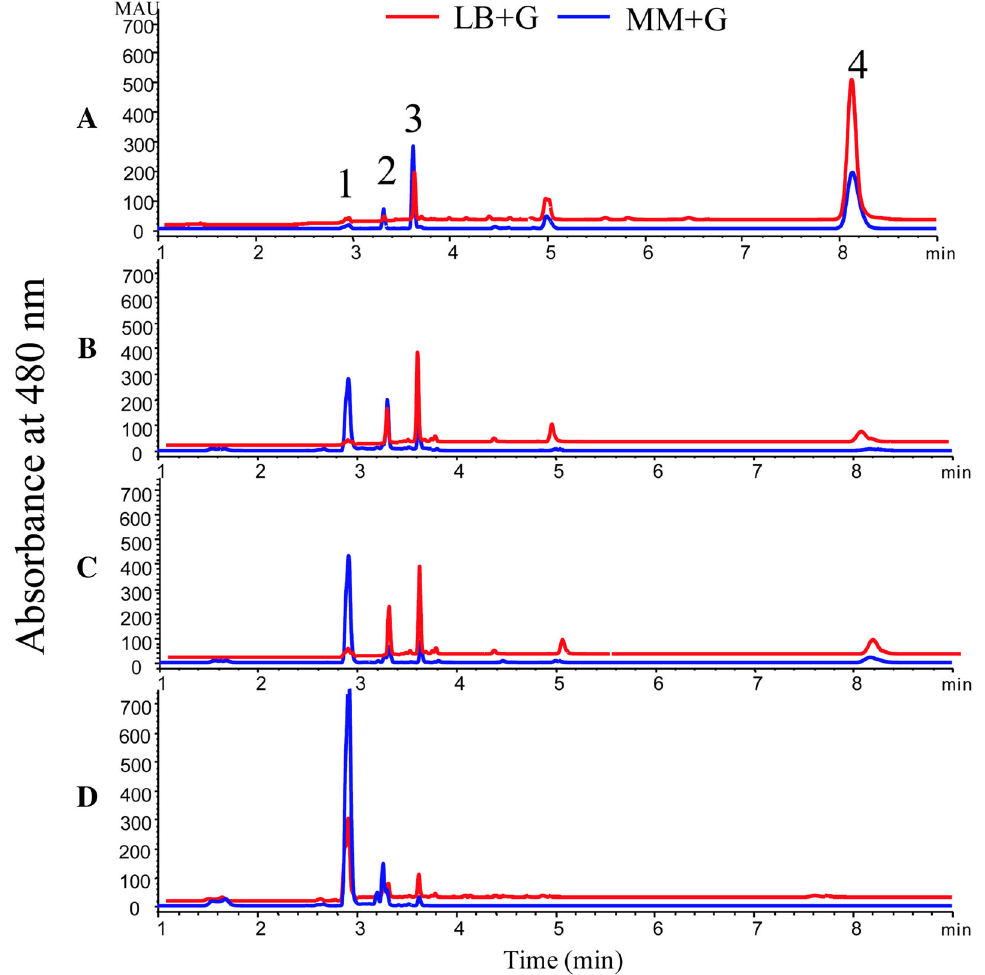
Fig. 4 UHPLC analysis of carotenoids in different E. coli strains harboring plasmid pCm- GadE p- AS . A BL21; B TG1; C JM109; D DH5a. 1 astaxanthin; 2 adonixanthin; 3 canthaxanthin; 4 b